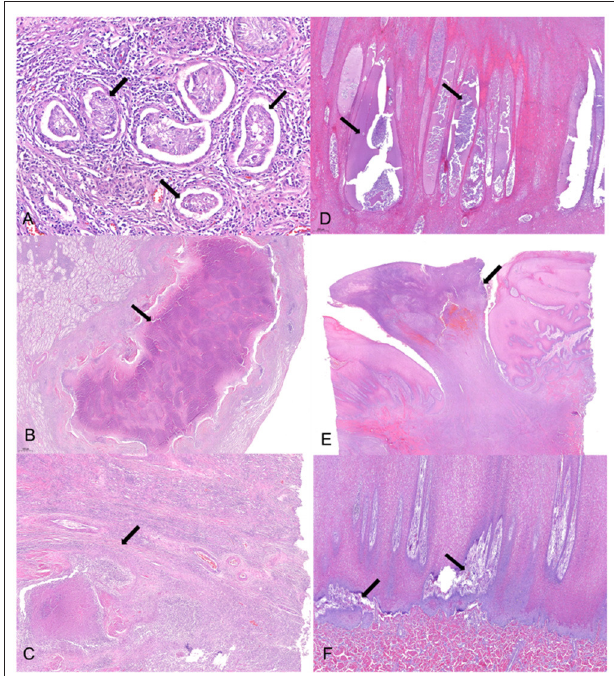
FIGURE 2 | Histopathological changes of the testicular and skin tissues. (A) Tubular degeneration with partial or complete loss (arrow) of germ cell layers were observed diffusely in the testis tissue. (B) Abscess (arrow) with polymorphonuclear inflammatory cell and necrotic debris enclosed with fibrotic tissue was observed in a broad portion of the testicular lobules. (C) Fibrosis (arrow) of the interstitial, perivascular, and peritubular regions was concurrently observed with necrosis and inflammation, resulting in tubular atrophy. (D) Pustules (arrow) containing neutrophils and cell debris were diffusely distributed in the thickening stratum spinosum epidermal layer. (E) Severe chronic focal ulcerative dermatitis (arrow) with hemorrhage was observed in the epidermal layer expanding into the dermis layer. (F) Papillary layer of dermal-epidermal junction was irregularly arranged (arrow) in the damaged skin. Hematoxylin and eosin stain; 4 × (E) , 20 × (B,D,F) , 40 × (C) , and 100 × (A)